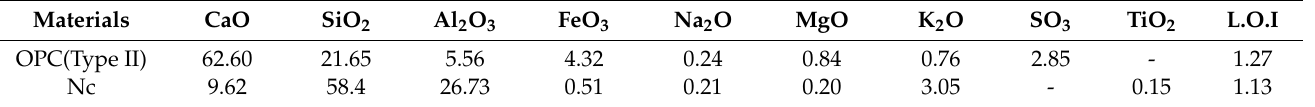
Table 1. Chemical compositions of OPC (Type II) and Nc